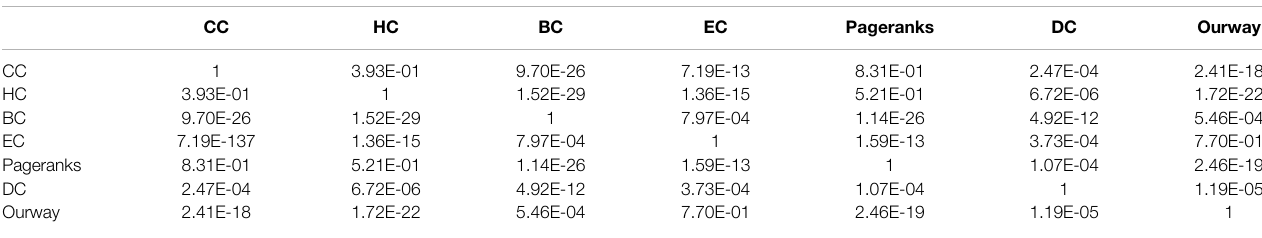
TABLE 5 | The p -value of these ways.